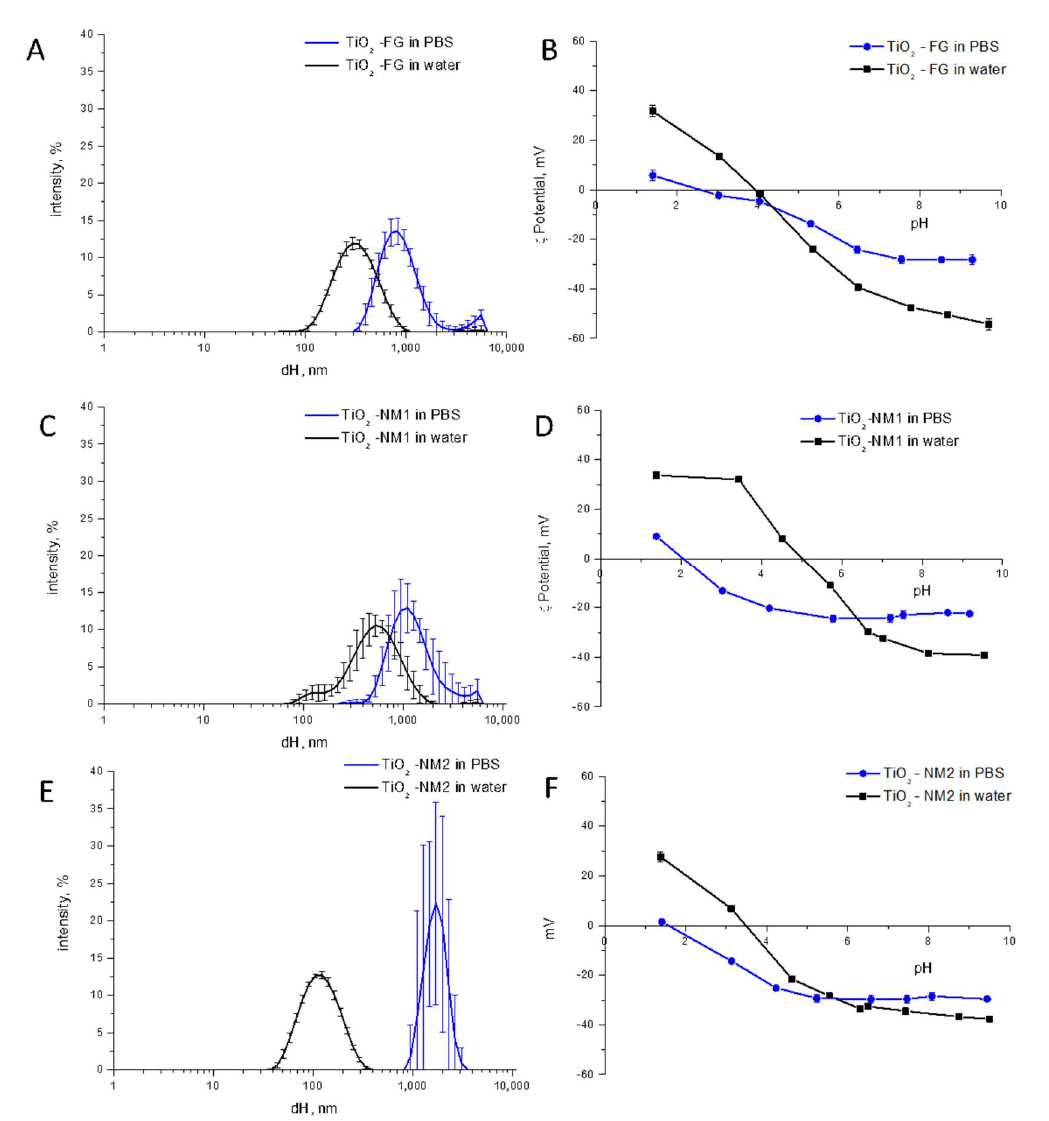
Figure 6. Effect of phosphate ions on the size distribution and ζ-potential of TiO 2 samples. Left panels: ζ-potentials vs. pH, expressed as mean value of three independent measurements ± SD. Right panels: Size distribution monitored by DLS. ( A , B ) TiO 2 -FG; ( C , D ) TiO 2 -NM1; ( E , F ) TiO 2 -NM2.